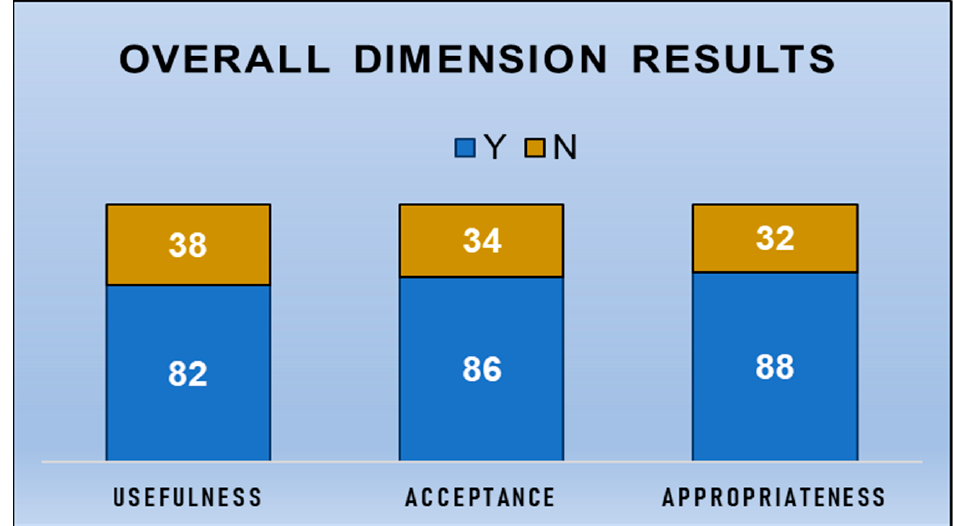
Figure 2. Dichotomous responses by dimensions. Same database (Fic L—Rel).